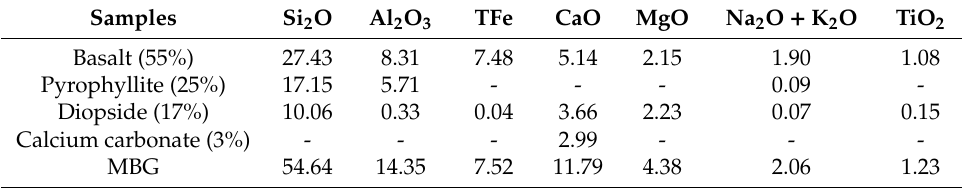
Table 3. Chemical composition of the